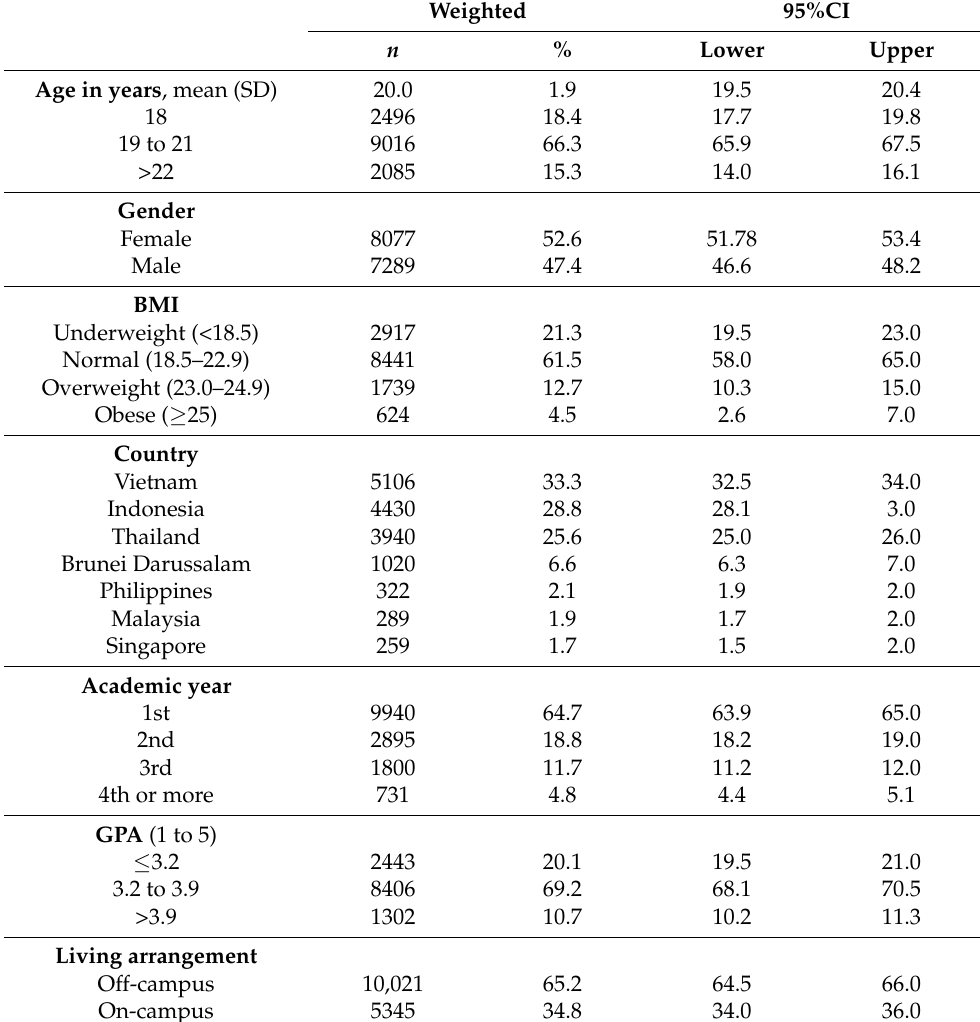
Table 1. Sociodemographic characteristics of university students ( n = 15,366).